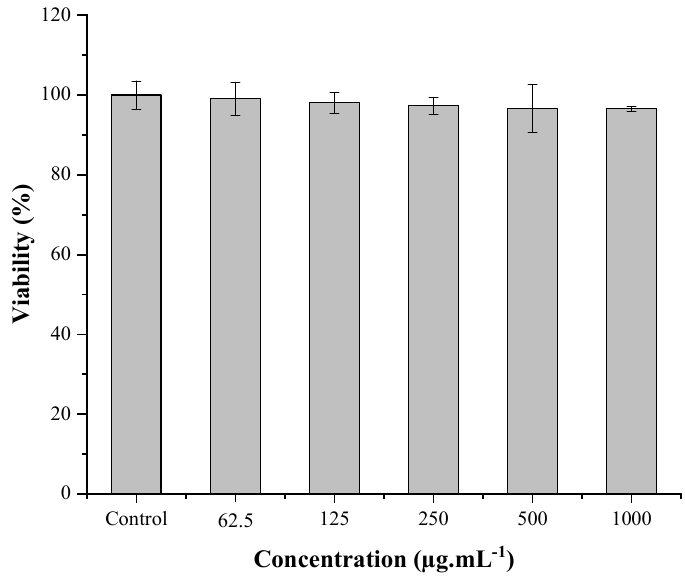
Figure 6. Cytotoxic evaluation of EPSwk in the Caco-2 cells by MTT reduction.